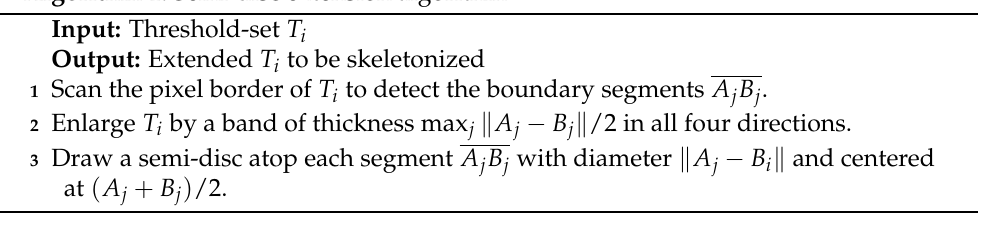
Algorithm 1: Semi-disc extension algorithm